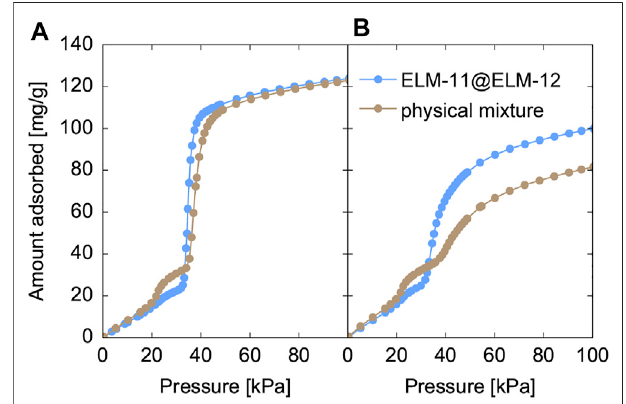
FIGURE 9 | Adsorption isotherms of CO 2 at 273 K in ELM-11@ELM-12 and a physical mixture of ELM-11 and ELM-12 (A) before and (B) after the air